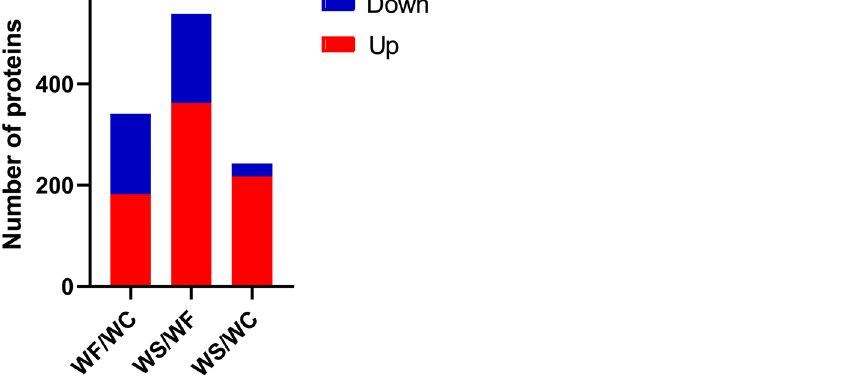
Figure 3. Histogram of the distribution of differentially expressed proteins in the WF/WC, WS/WF and WS/ WC groups. Red and blue indicate significantly up-regulated and down-regulated proteins,